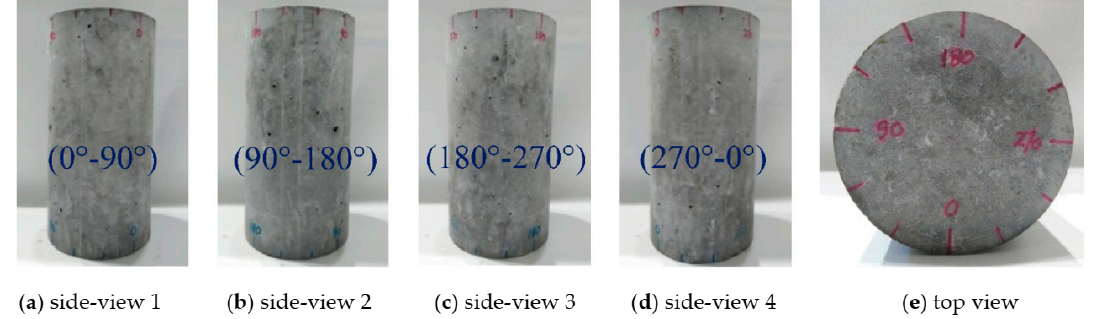
Figure 3. Marking of